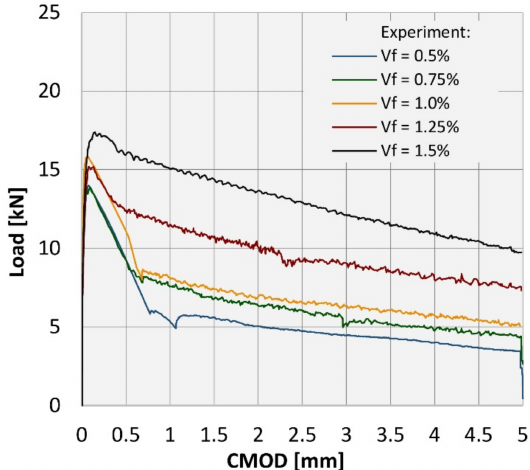
Figure 5. Average load-CMOD curves obtained in the flexural